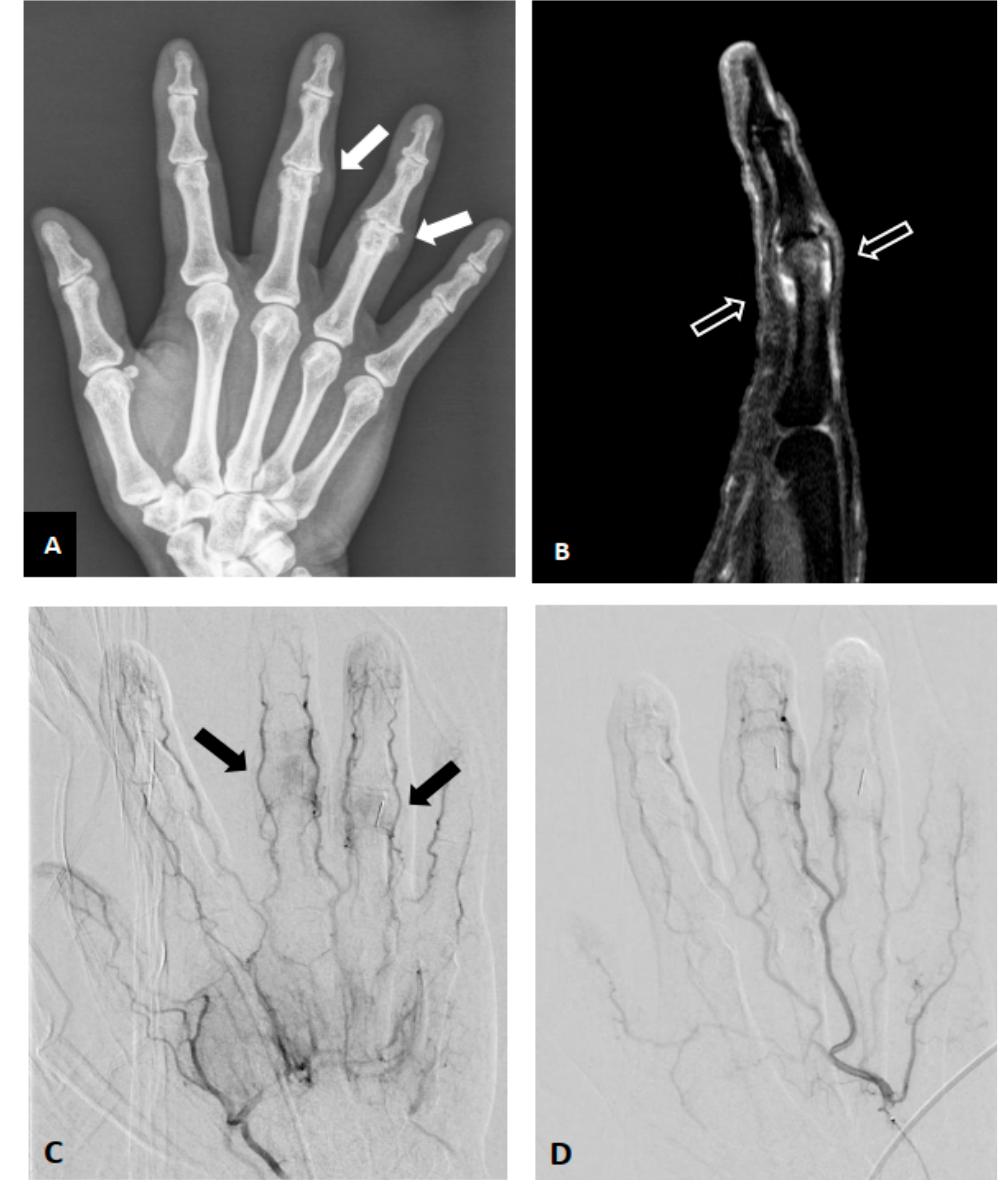
Figure 1. Representative pre- and postprocedural images of the right hand 3rd and 4th proximal interphalangeal (PIP) joint osteoarthritis in a 50-year-old female with chronic pain and swelling. The results of all rheumatoid profile blood tests were within the normal ranges. ( A ) Right hand plain film revealed joint space narrowing with spurs formation (white arrows). ( B ) Preprocedural sagittal MRI (fat-saturated T1-weighted post-contrast) of the 3rd finger revealed synovium thickening and enhancement at approximately the 3rd PIP joint (blank arrows). ( C ) Preprocedural angiography of the right ulnar artery showed angiogenesis (black arrows) overright 3rd and 4th PIP joints. ( D ) Postembolization angiography via ulnar artery indicated elimination of angiogenesis after emboli- zation. The patient’s joint pain and swelling both were improved after treatment.